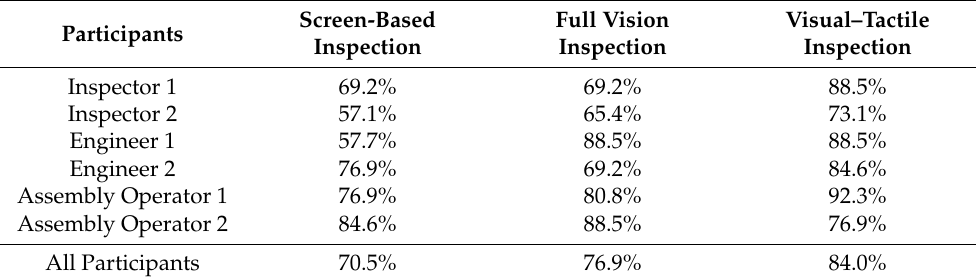
Table 3. Inspection accuracy of each participant by inspection